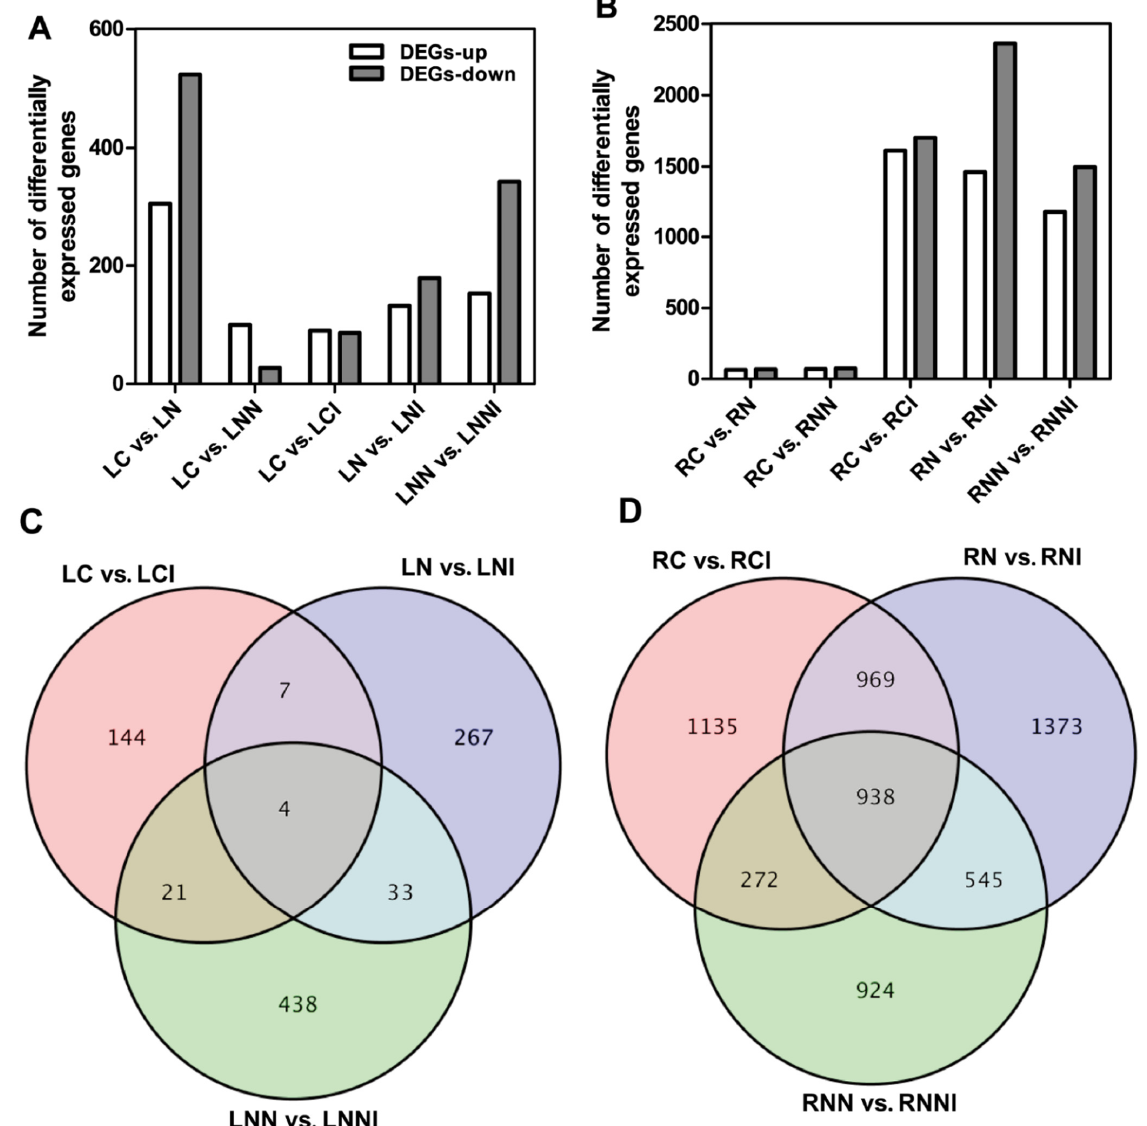
Figure 3. Distribution of differentially expressed genes (DEGs) identified by RNA-Seq analysis from a comparison of maize seedlings supplemented with no nitrogen, 4 mmol L − 1 NO 3 − or 10 mmol L − 1 NO 3 − , and treated with 5 ppm IMI for 48 h (shoots, A), or 24 h (roots, B), with respect to the control (no IMI treatment).The Venn diagram of the number of differentially expressed unigenes in each comparison group (C and D).